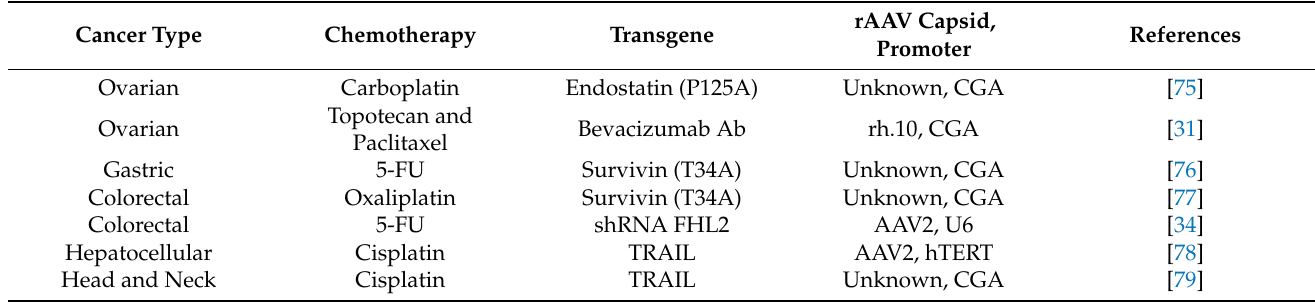
Table 2. Preclinical studies conducted using rAAV and chemotherapy